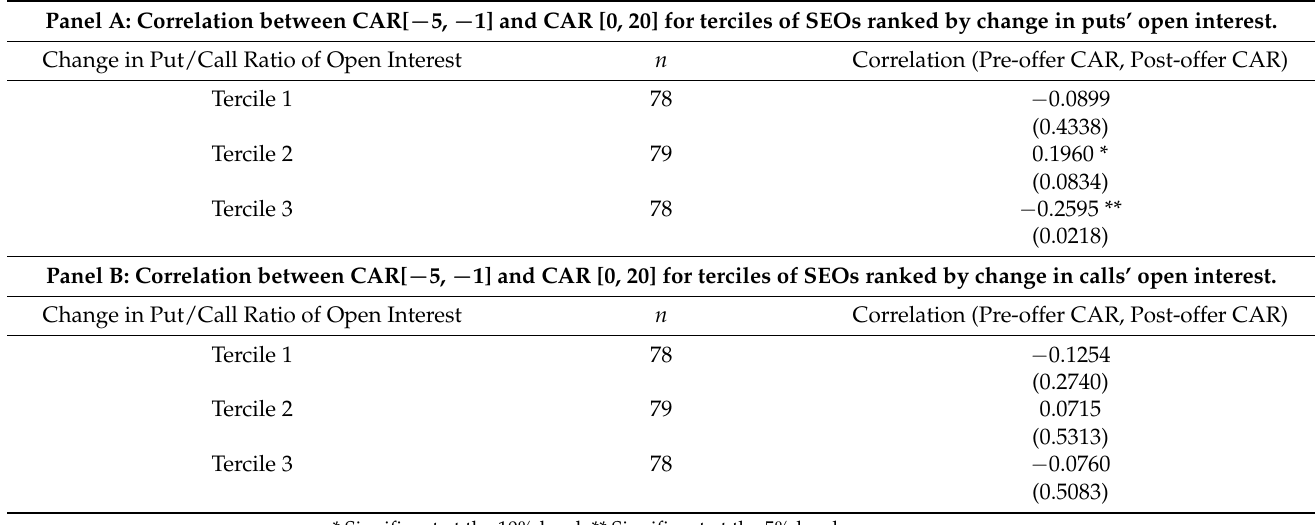
Table 7. Correlation between pre-offer CAR and post-offer CAR by categories. Panel A: Correlation between CAR[ − 5, − 1] and CAR [0, 20] for terciles of SEOs ranked by change in puts’ open interest. Change in Put/Call Ratio of Open Interest n Correlation (Pre-offer CAR, Post-offer CAR) Tercile 1